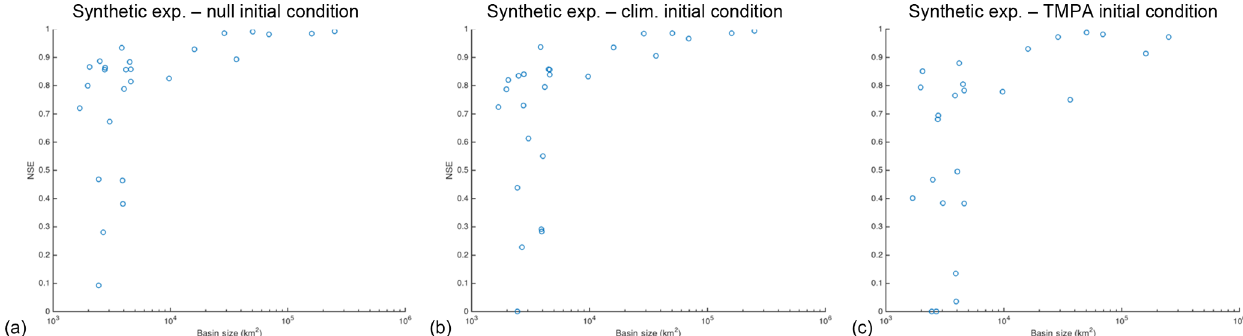
Figure 6. Distribution of NSE values for each of the evaluation sites versus the size of the upstream area for each gauge. The ordering and experiment names are the same as those in Fig.